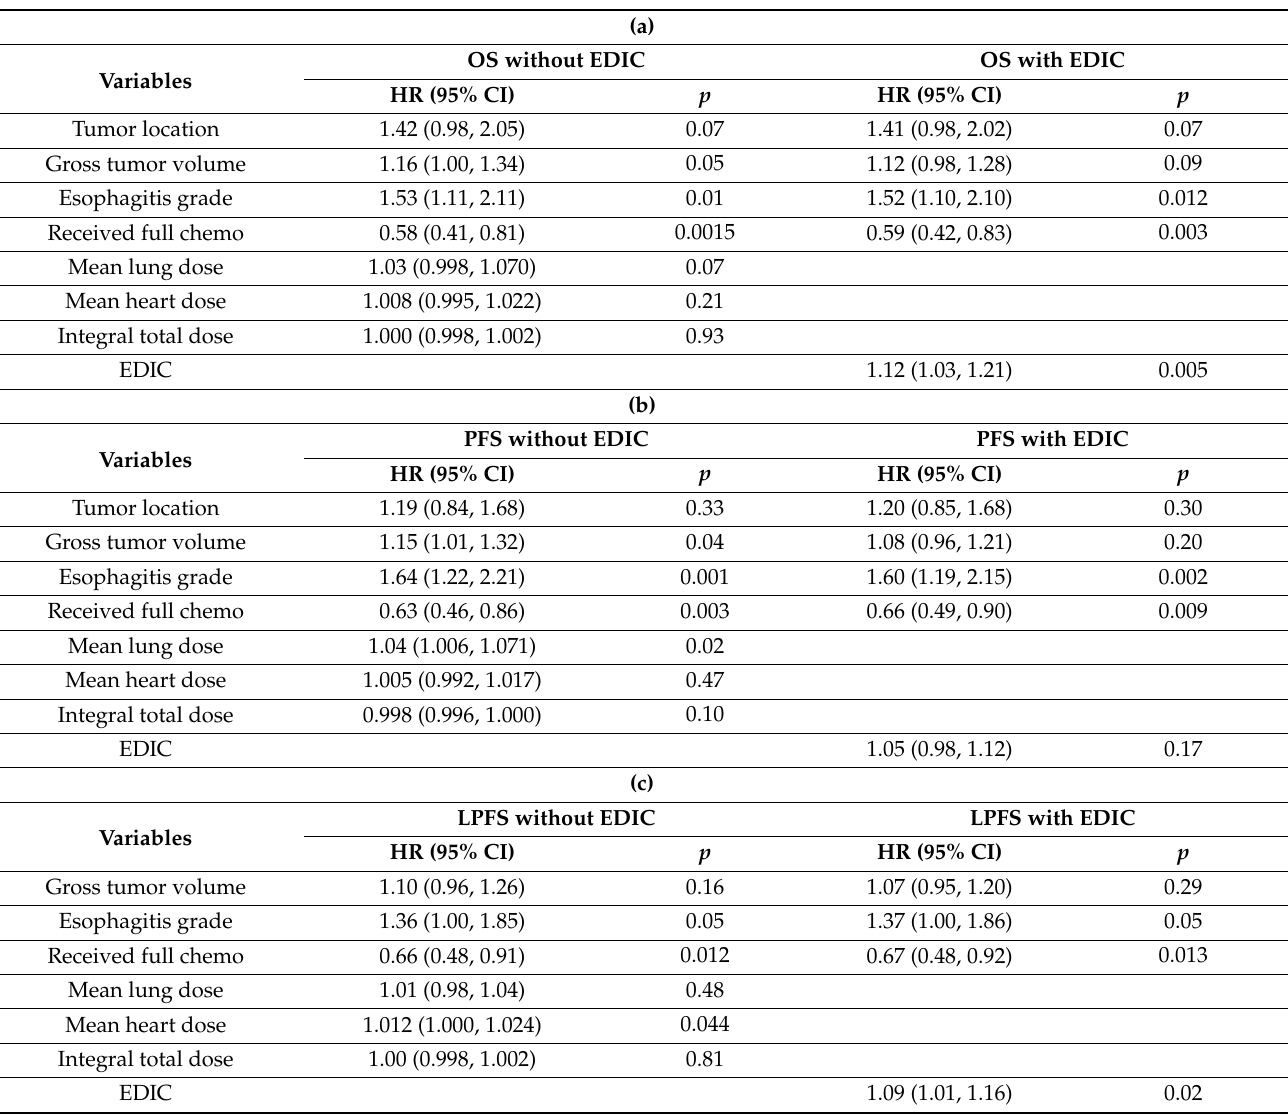
Table 2. Stratified multivariable analyses with stratification of patients according to the actual received RT dose.